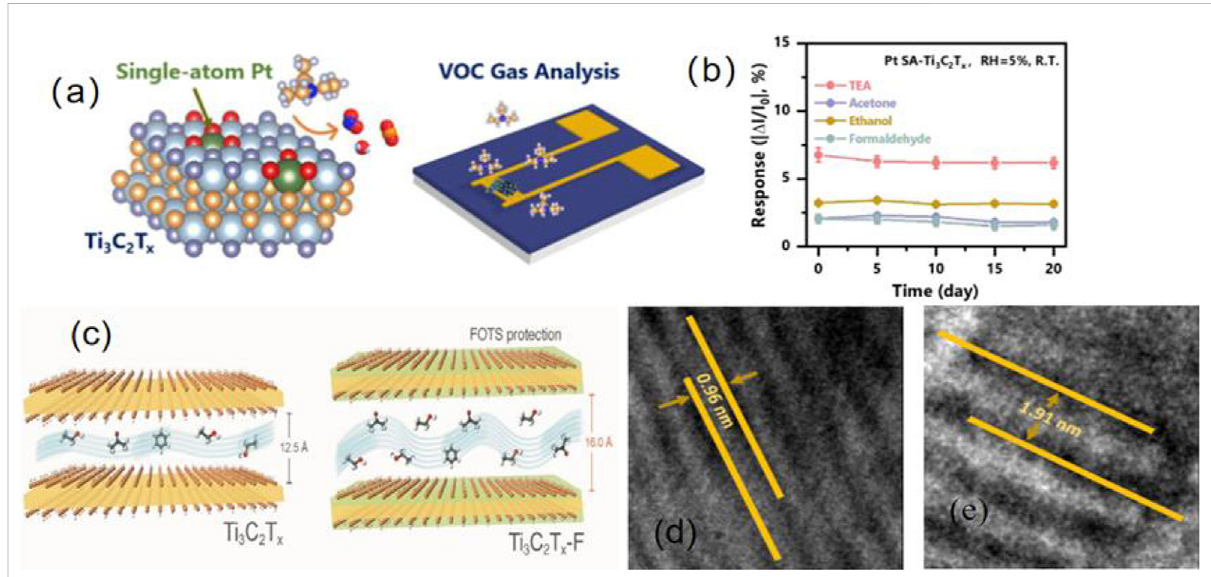
FIGURE 2 (A) Modi fi ed Pt atoms into sensors prepared in Ti3C2Tx. (B) Response rate of Pt-Ti3C2Tx sensors to various VOCs gases at room temperature for 20 consecutive days (adapted from Zong et al., 2022). (C) Interlayer distance between Ti3C2Tx materials before and after incorporation into FOTS. (adapted from Chen et al., 2020a) (D – E) Interlayer spacing of Ti3C2Tx materials before and after incorporation of S elements was observed under TEM (adapted from Shuvo et al.,